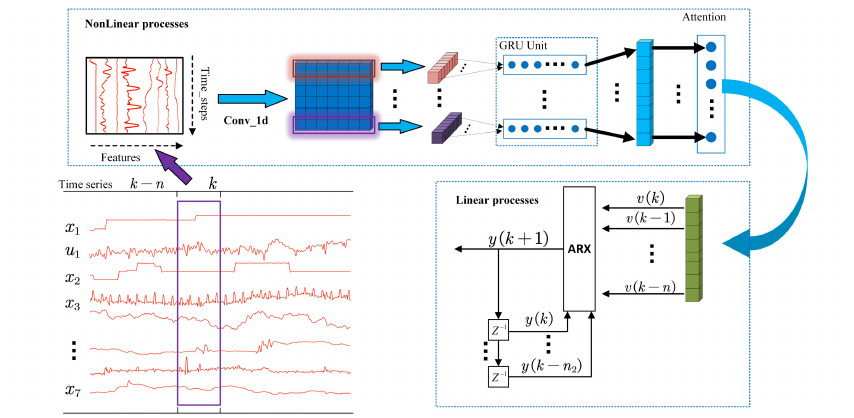
Figure 4. CGA-ARX model.